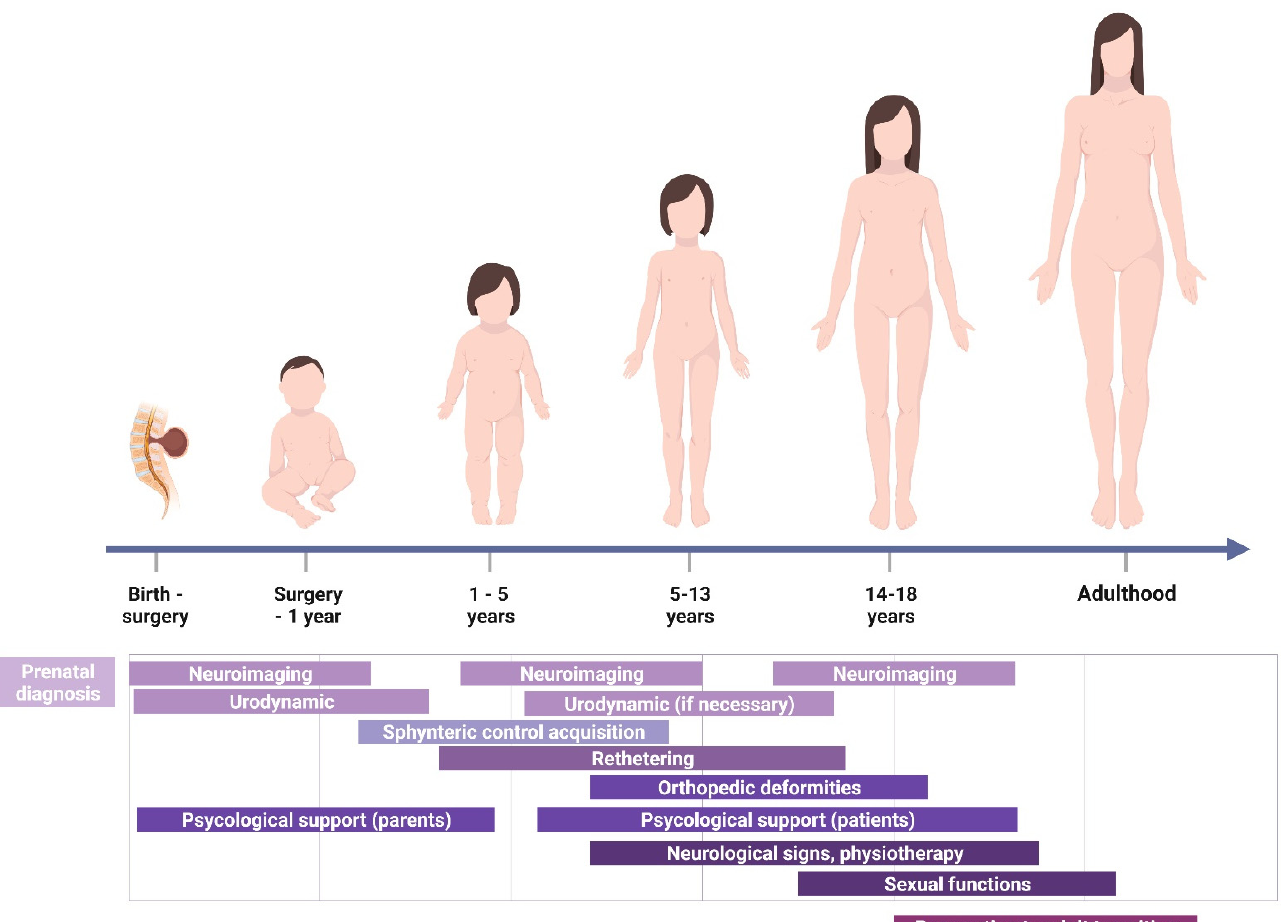
Figure 1. Overview of specific highlights and pitfalls during the children’s growth (created with BioRender.com).